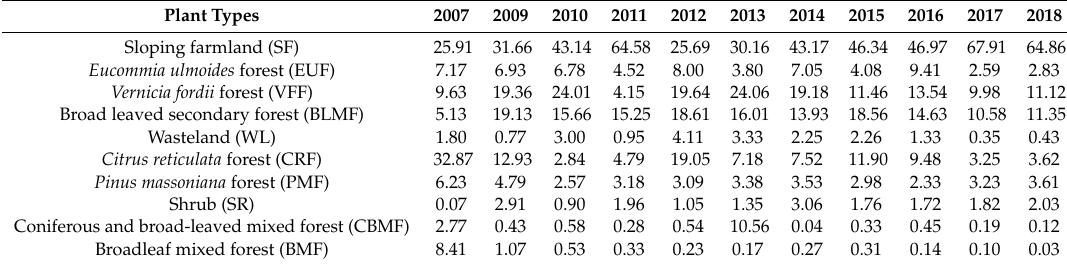
Table 5. Contributions from each vegetation type between 2007 and 2018 (%). Plant Types